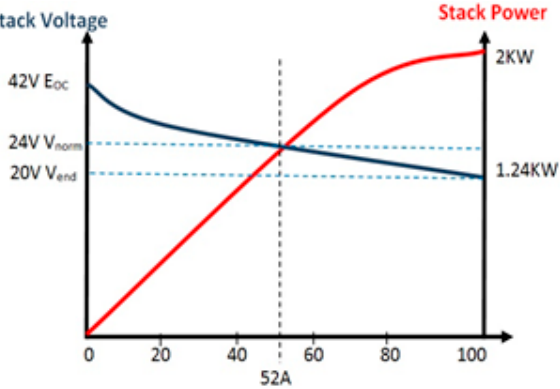
Figure 8. Voltage — current and power — current fuel cells ’ stack characteristics. Figure 8. Voltage—current and power—current fuel cells’ stack characteristics. Figure 8. Voltage—current and power—current fuel cells’ stack characteristics.